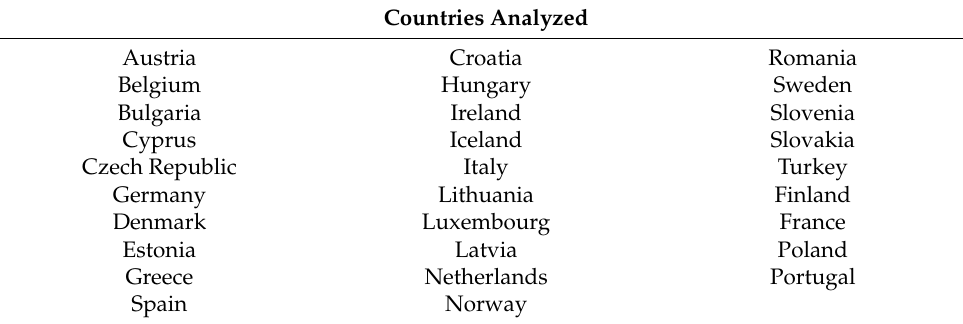
Table 2. Countries included in the